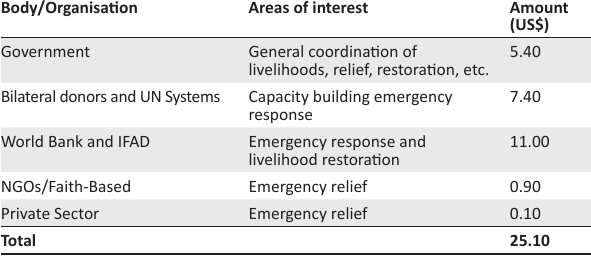
TABLE 2: Direct emergency funding for disaster relief in Ghana.